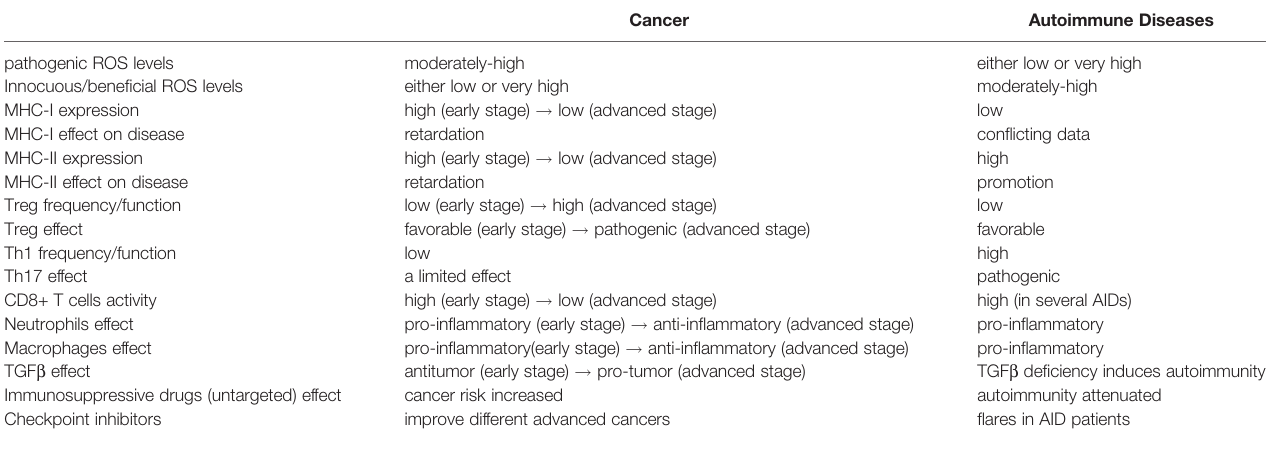
TABLE 1 | A comparison of cancer and autoimmune diseases in terms of immunological properties, ROS effect, TGF b effect and drug